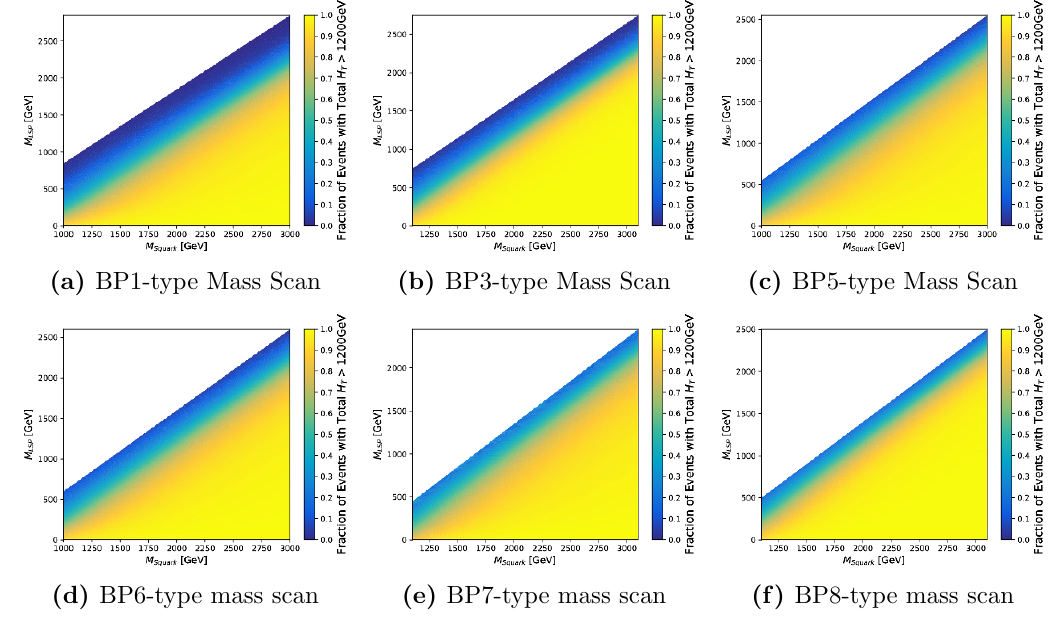
Figure 6. Fraction of events with total H T > 1200 GeV for the BP1-BP8-type mass